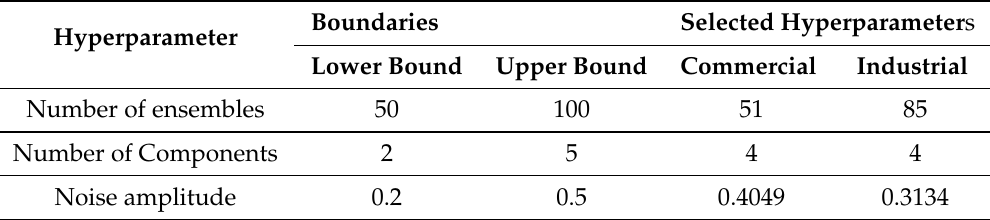
Table 2. Search boundaries of the CEEMD